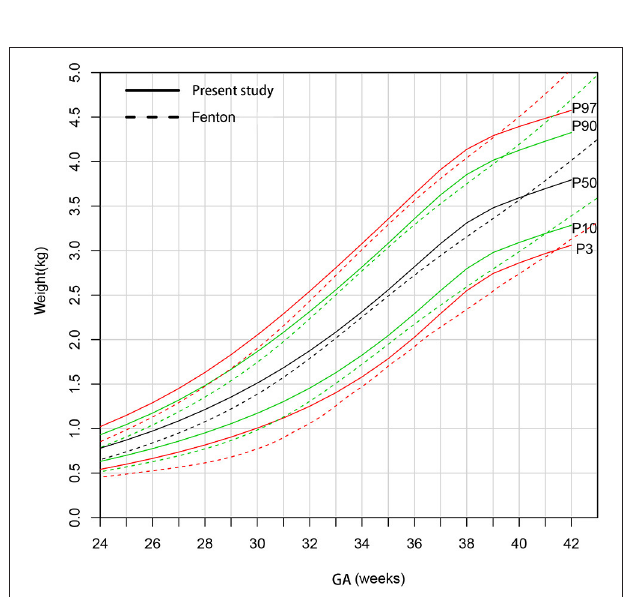
FIGURE 3 | Comparison of birthweight (kg) curves by gestational age between the present study and Fenton curve (male).